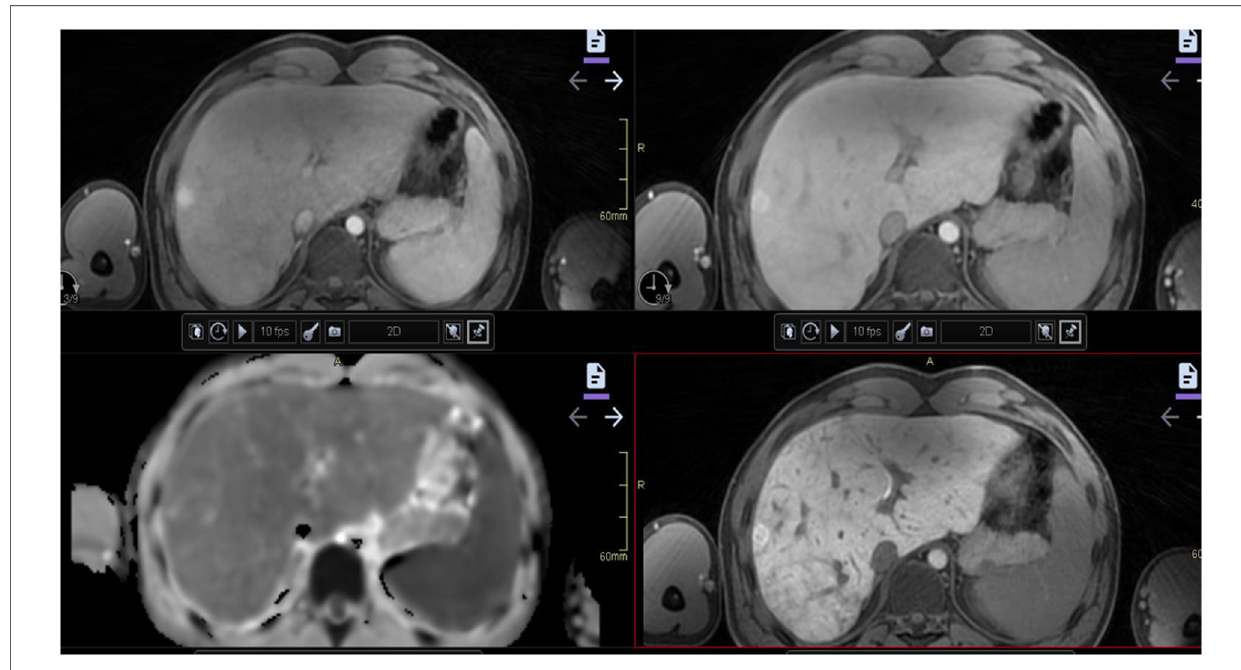
FIGURE 10 An 18-year-old boy born with double inlet left ventricle and pulmonary stenosis with a Fontan circulation. Satisfactory ventricular function was observed. Abdominal MRI was performed as a regular follow-up before transition to adult care. A 14 mm nodule not visible on ultrasound was found in the lateral part of the right liver lobe on MRI. Dynamic contrast-enhanced MRI with hepatocyte speci fi c contrast agent was performed, revealing hyper- enhancement in arterial phase (upper left) and in late portal venous phase (upper right) as well as slightly irregular in hepatocyte phase (after 20 min) (lower right). The nodule is dif fi cult to see clearly on the diffusion-weighted image (lower left). The nodule was interpreted with features of a probably benign nodule, and close follow-up with contrast-enhanced MRI was recommended. MRI, magnetic resonance